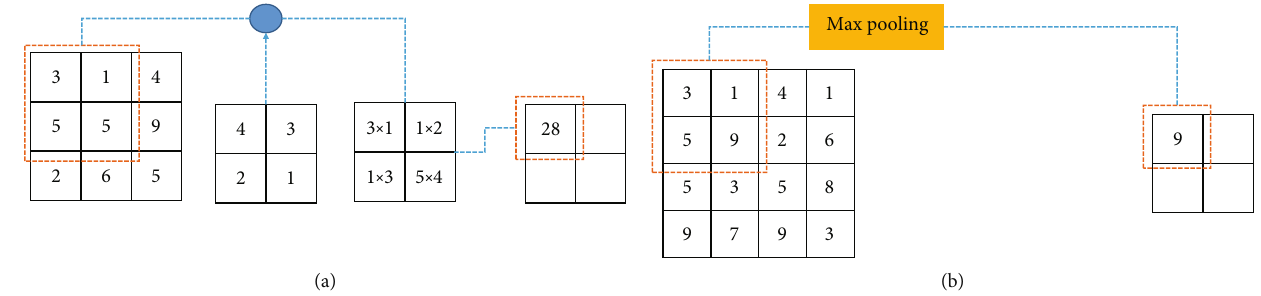
Figure 4: Two operations of convolutional neural network: (a) convolution operation and (b) maximum pooling